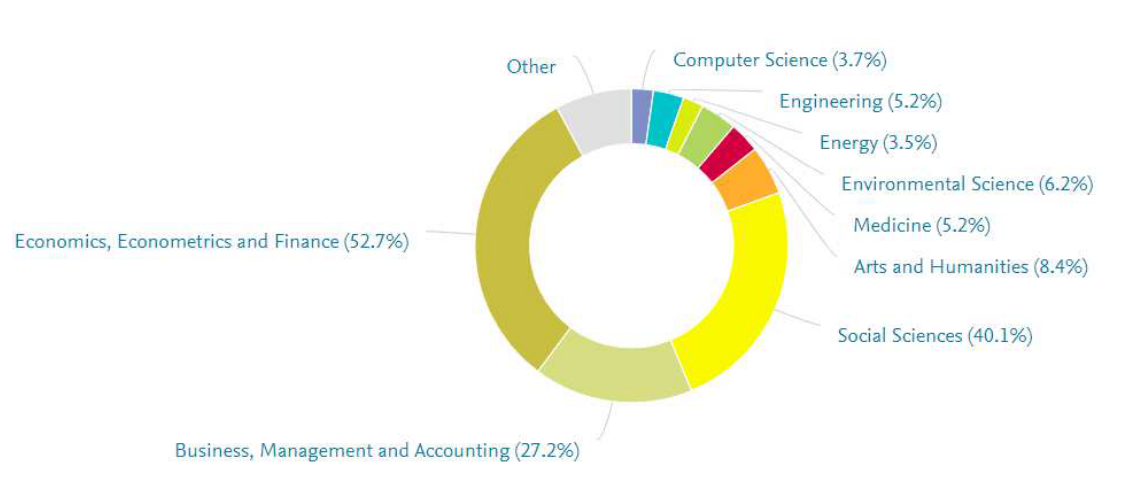
Figure 9. Structural analysis of public debt by subject